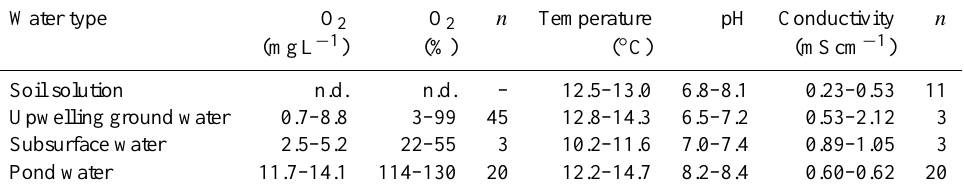
Table 1. Characteristics of soil solution, upwelling ground water, subsurface water and pond water of the Chicken Creek Catchment in April 2010. Soil solution was measured at 30cm depth, upwelling ground water within the upper 4cm of the stream sediment, and subsurface water at 60–70cm sediment depth. Data for the pond water refer to a depth profile from 0 to 1.5m in the pond water column. n.d. = not determined.